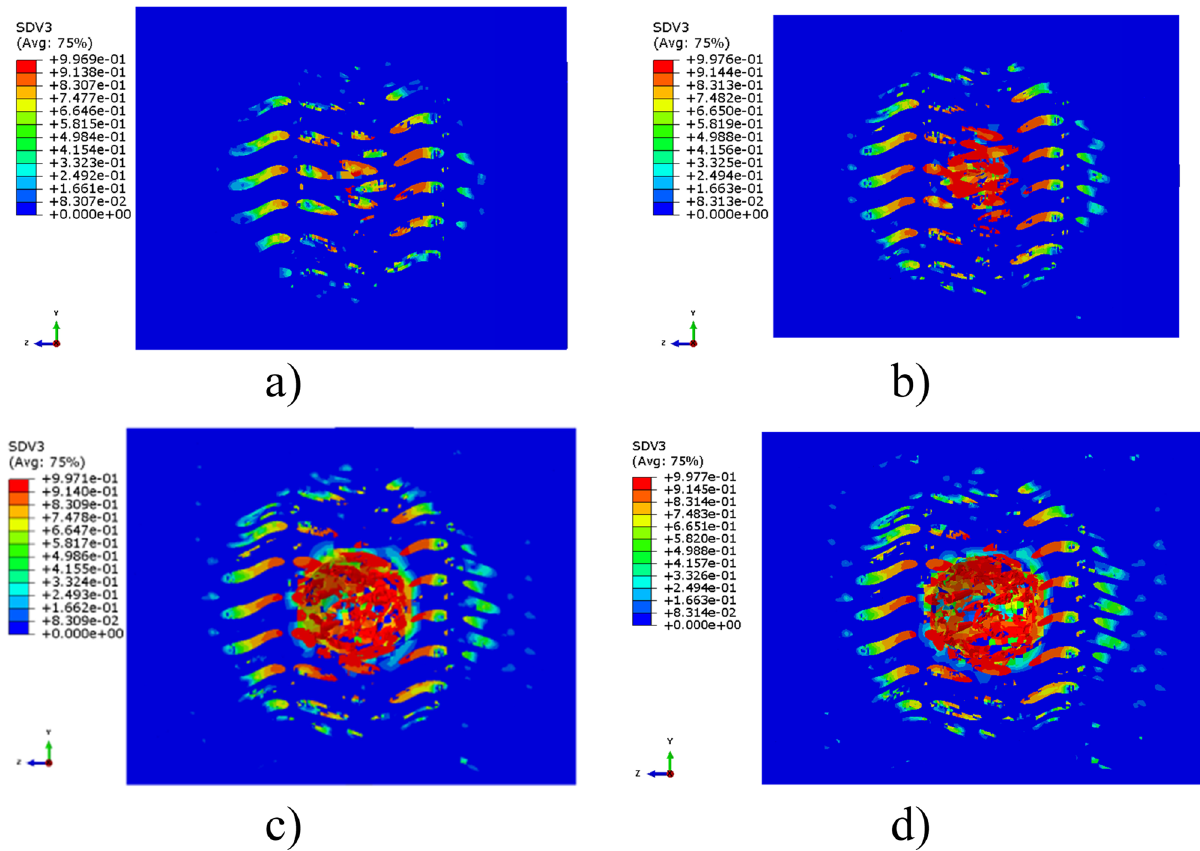
Figure 21: Transverse tensile damage of the specimens after a di ff erent number of impact tests: ( a ) 1st impact, ( b ) 5th impact, ( c ) 10th impact, and ( d ) 20th